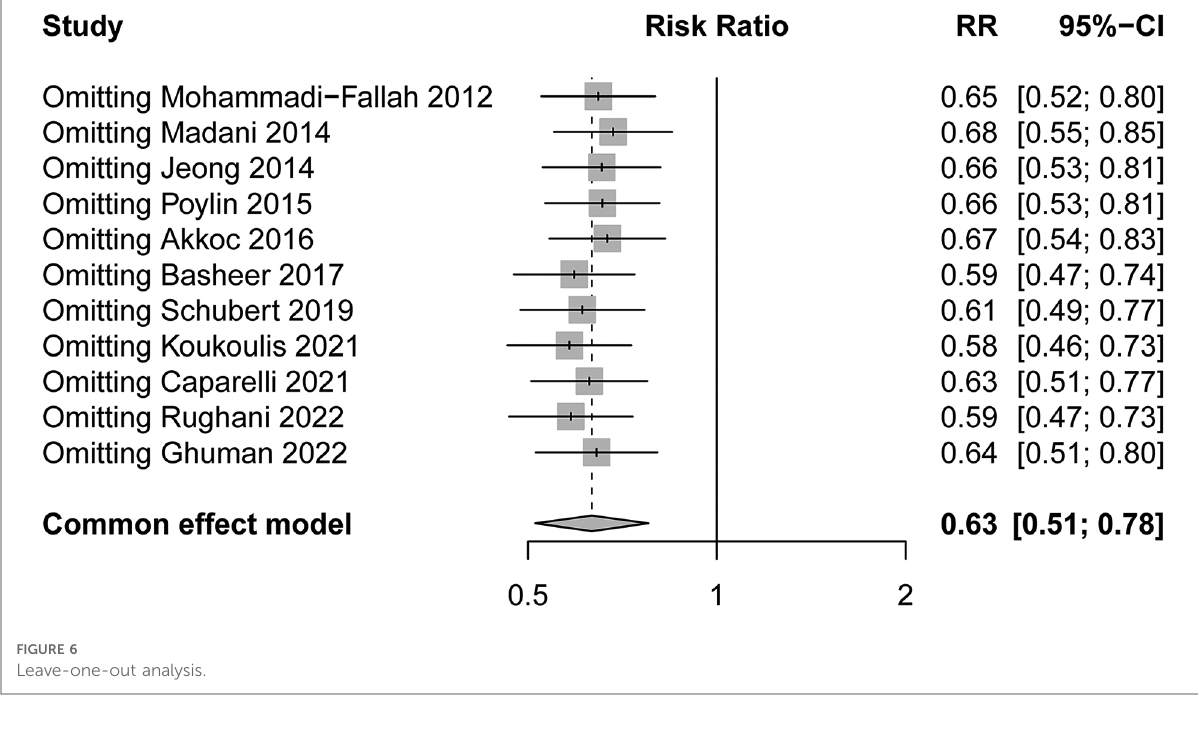
FIGURE 6 Leave-one-out analysis.